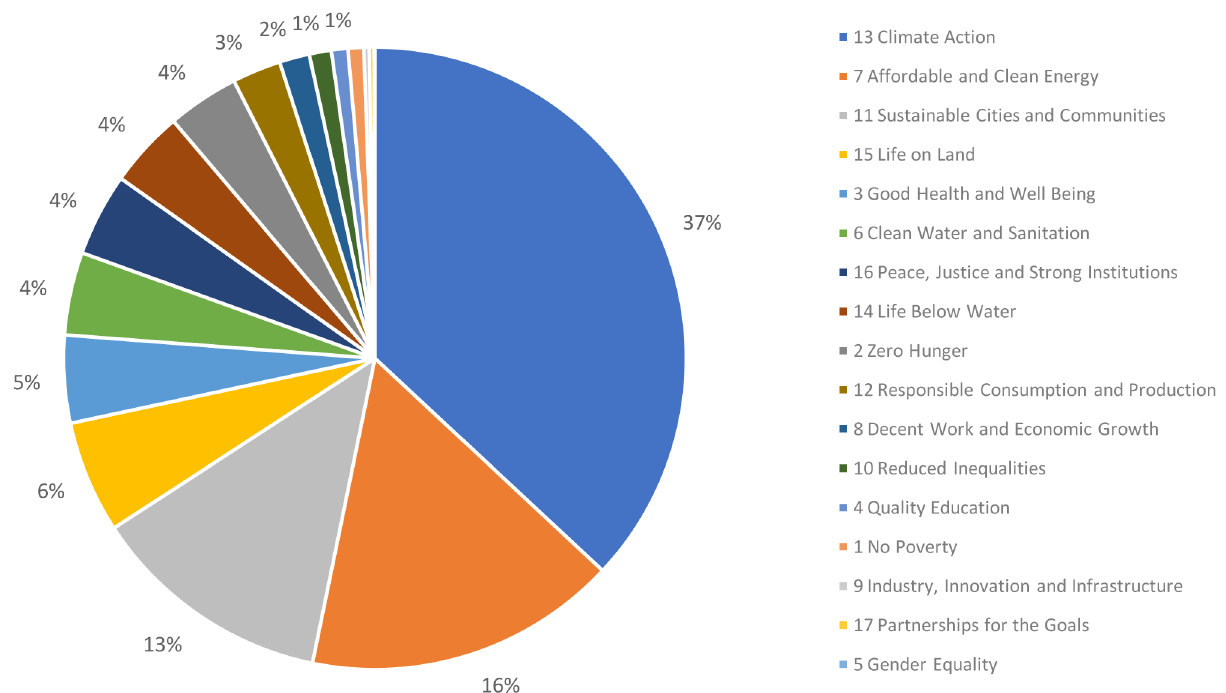
Figure 2. Relative proportion of the different SDGs covered by T&F research corpus (based on number of article tags).